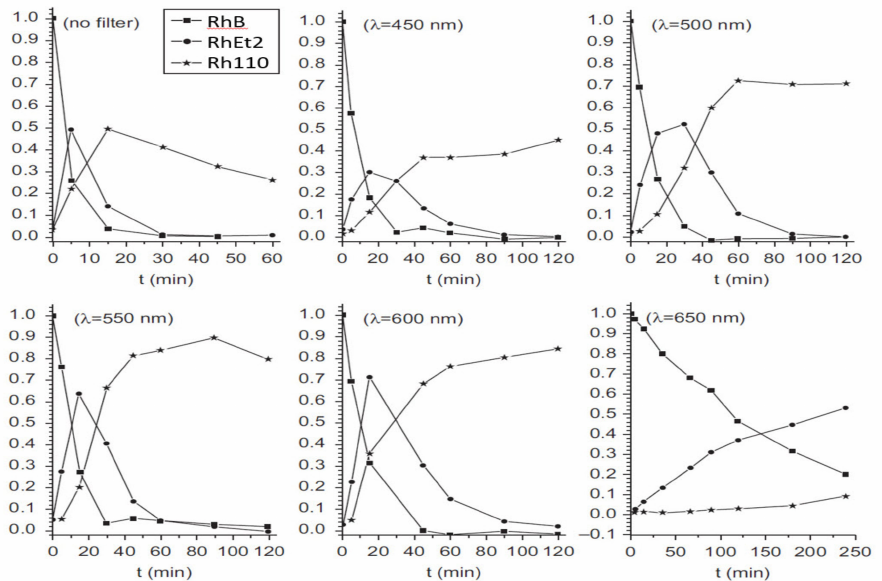
Figure 3. PCA analysis results: evolution of the RhB dye and products RhEt2 and Rh110 irradiated in presence of In 2 S 3 with light unfiltered or using band-pass filters of wavelength λ . Results scaled relative to the dye absorption at t = 0 (Adapted from ref. [127]).